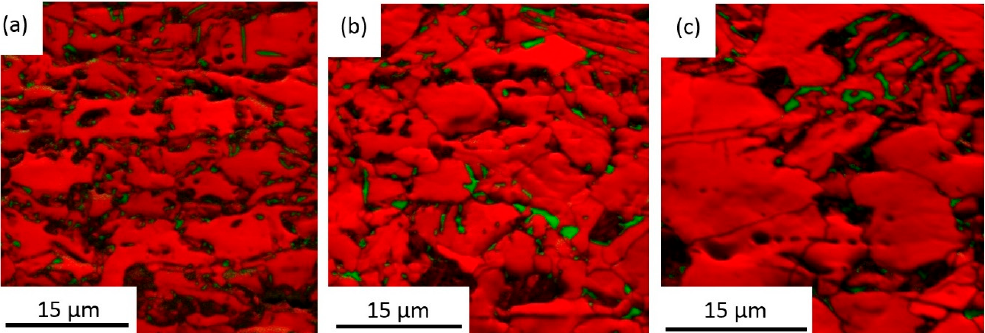
Figure 5. IQ + phase map for each steel. In the IQ map, dark zones correspond to a low IQ value, and in the phase map, the BCC structures are shown in red (ferrite, bainite, martensite) and the FCC Figure 4. SEM micrographs of representative samples of each steel: ( a ) F/P, ( b ) HA900, ( c ) HA1100. structures are shown in green (austenite). ( a ) F/P steel, ( b ) HA900 steel, ( c ) HA1100 steel. Step size 60 A/M: Austenite/Martensite, F: Ferrite, B: Bainite [28]. nm [28].